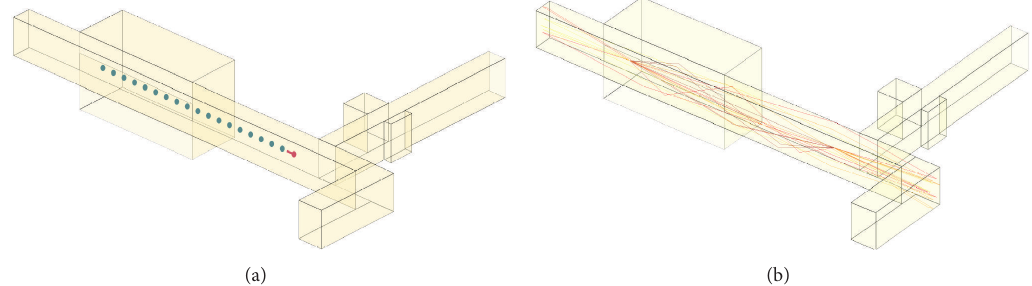
Figure 6: (a) Scenario model of floor 2 in Mechanical Engineering Building. (b) A snapshot of the ray tracing result.